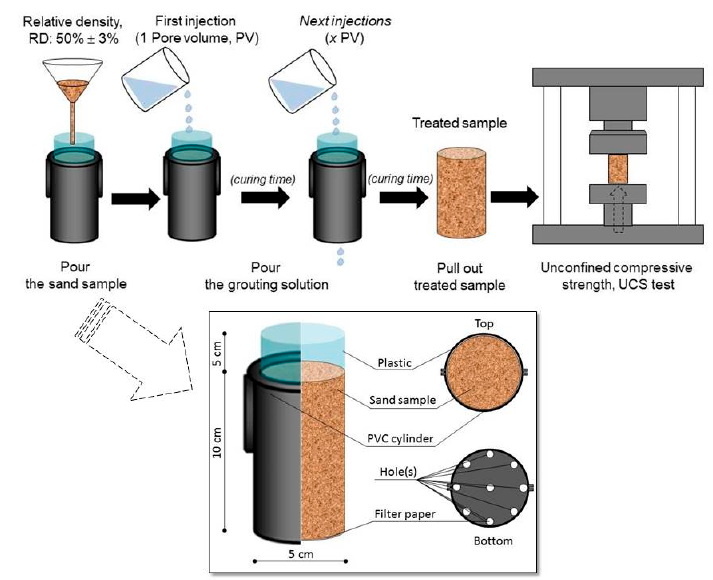
Figure 6. Procedure of PVC cylinder tests [10].